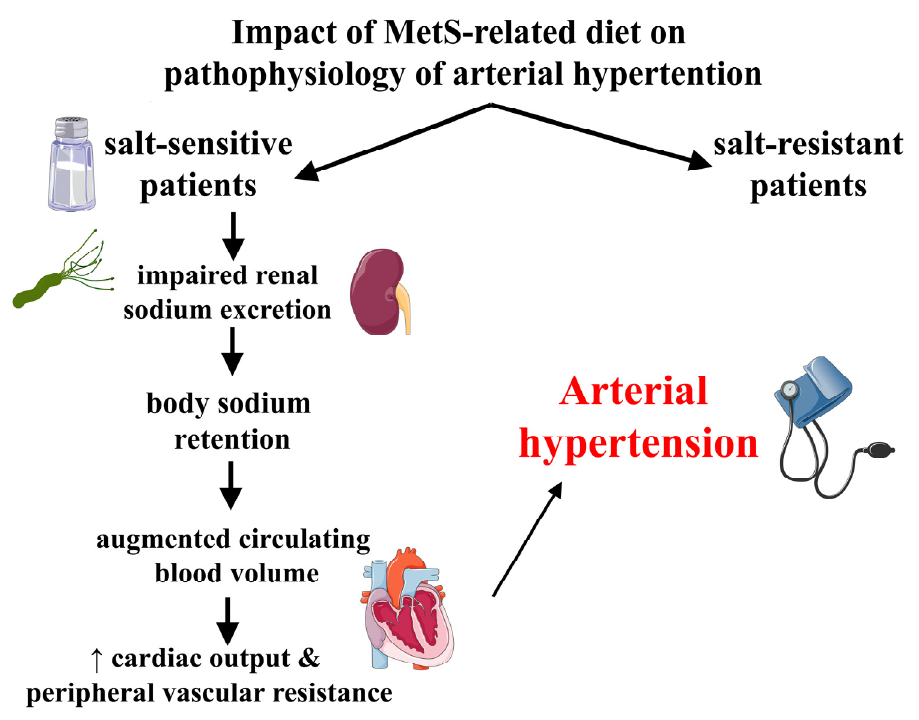
Figure 2. Simplified pathogenetic approach of diet (i.e., salt) impact on arterial hypertension. Patients with Helicobacter pylori infection belong also to the salt-sensitive category.